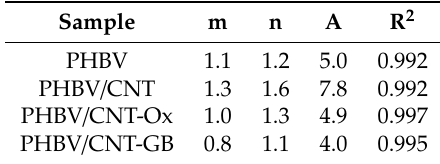
Table 4. Values of m, n, A, and correlation factor found by fitting the curves to the SB